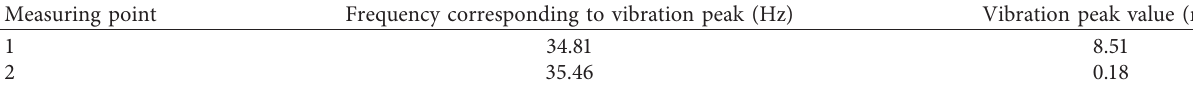
Table 3: Comparative analysis of vibration test results under fixed idle speed condition. Measuring point